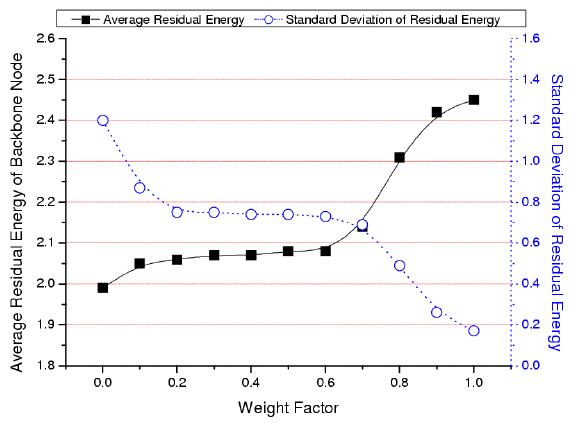
Figure 3. Average and standard deviation of residual energy.